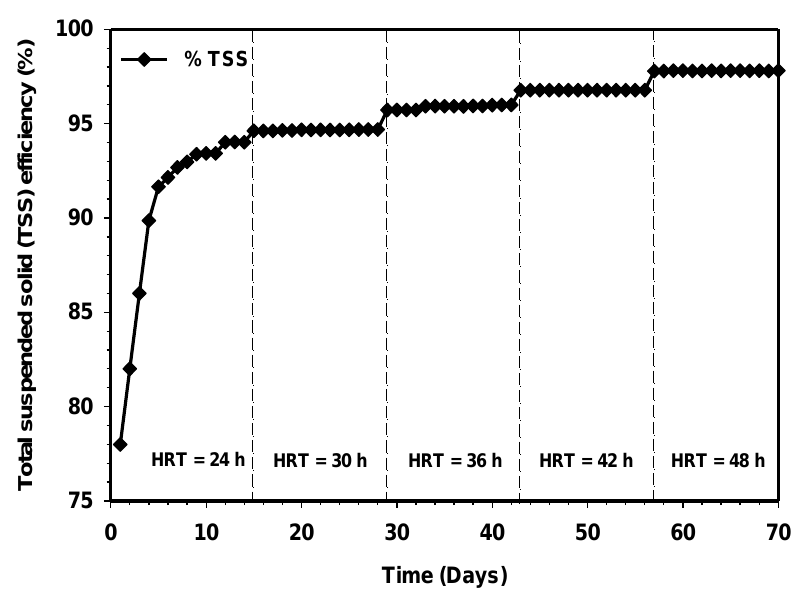
Figure 6. Variation of TSS removals efficiency relative to increasing contact time .